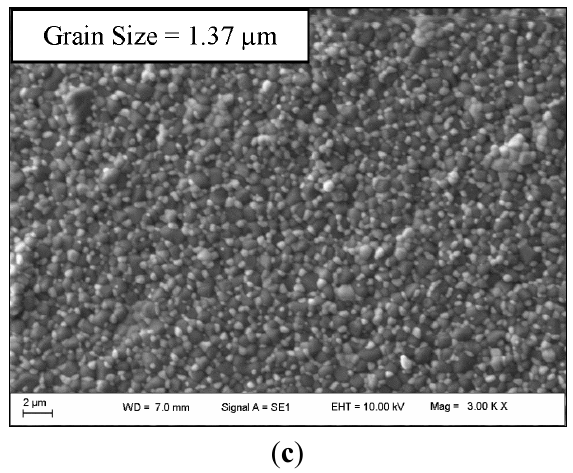
Figure 11. ( a ) T s = 1650 °C and solid loading = 61% (SEM image); ( b ) SEM image of ZTA samples with T s = 1650 °C and solid loading = 62% (SEM image); ( c ) T s = 1550 °C and solid loading = 62% (SEM